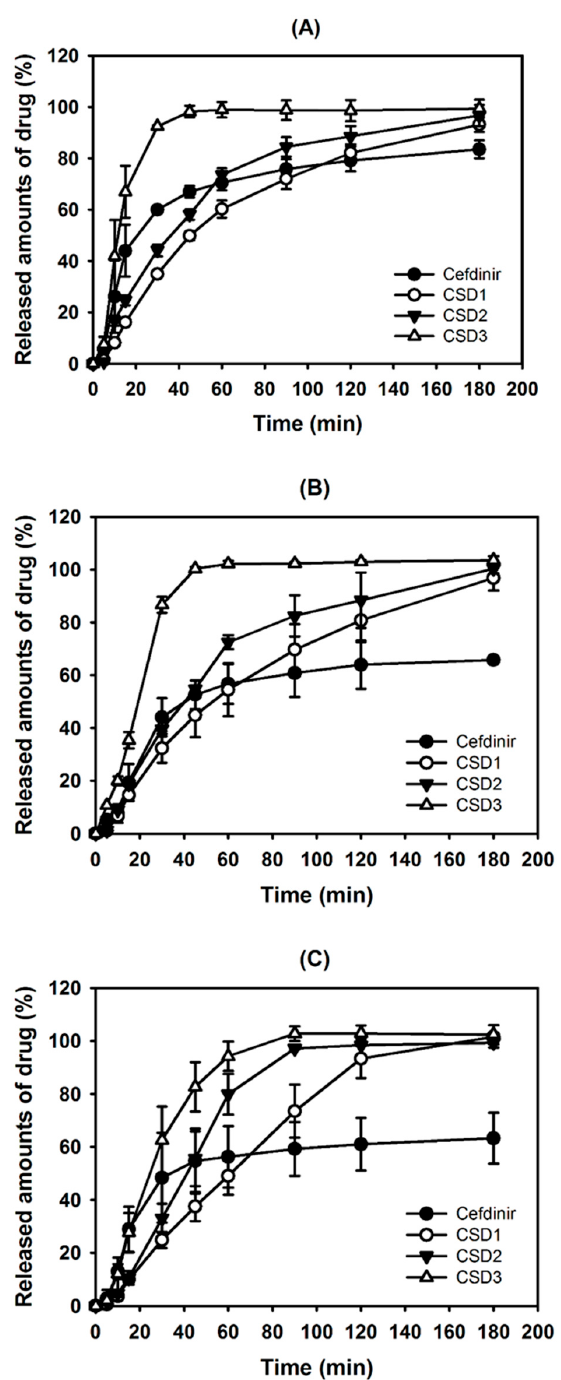
Figure 7. The dissolution curve of cefdinir, CSD1, CSD2, and CSD3 at pH 1.2 ( A ), pH 4.0 ( B ), and water ( C ). Data are presented as means ± standard deviation ( n = 3).